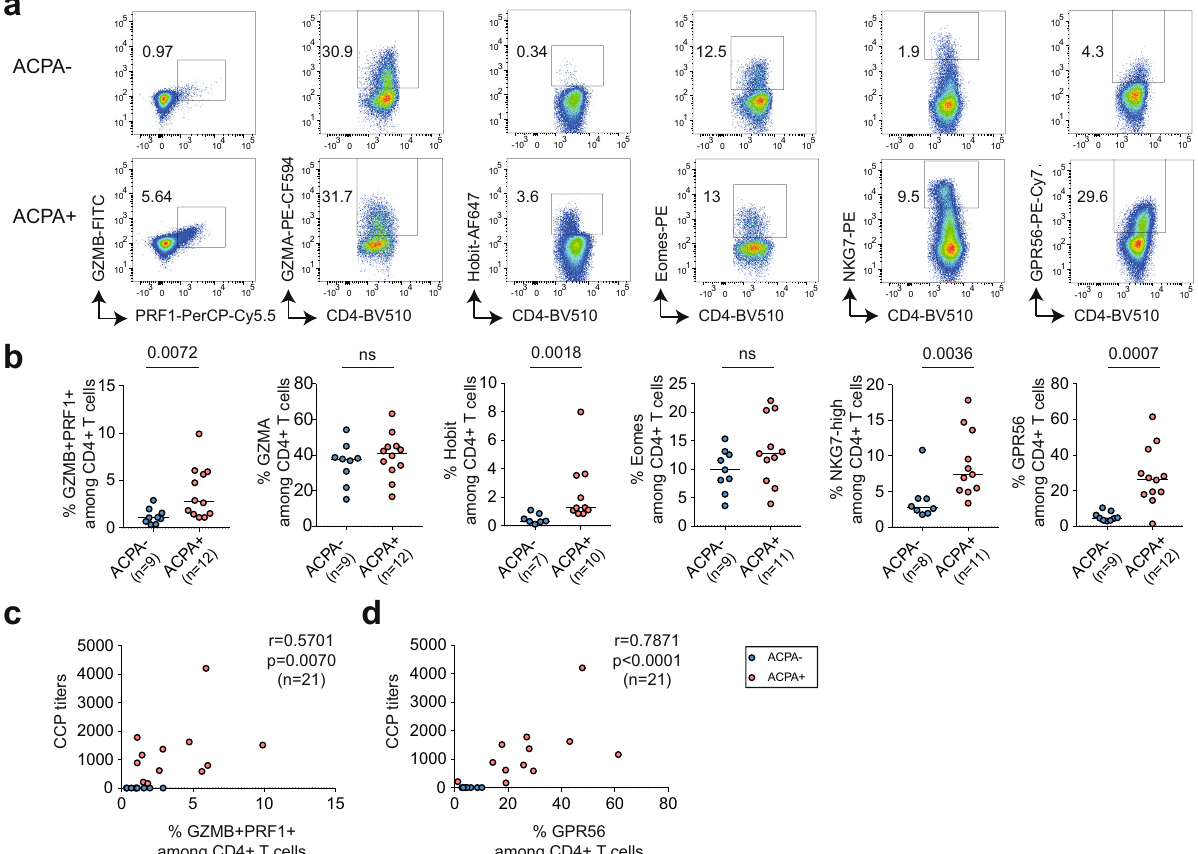
Fig. 1 Cytotoxic CD4 + T-cell frequency in synovial fl uid of ACPA − and ACPA + RA patients. a Representative fl ow cytometry dot plot staining of effector molecules, receptors and transcription factors associated with cytotoxic functions in CD4 + T cells from synovial fl uid (SF) from ACPA − (upper panel) and ACPA + (lower panel) RA patients, quanti fi ed in b , (ACPA − , n = 7 – 9) (ACPA + , n = 10 – 12). Line represents median, two-tailed Mann – Whitney U test, P = 0.0072 (%GZMB + PRF1 + ), ns (%GZMA), P = 0.0018 (%Hobit), ns (%Eomes), P = 0.0036 (%NKG7-high), P = 0.0007 (%GPR56), ns: not signi fi cant. c Correlation between the frequency of GZMB + PRF1 + in CD4 + T cells in SF and the level of serum anti-CCP (cyclic citrullinated peptide) antibodies, n = 21, Spearman two-tailed test, P = 0.0070. d Correlation between the frequency of GPR56 in CD4 + T cells in SF and the level of anti-CCP (cyclic citrullinated peptide) antibodies, n = 21, Spearman two-tailed test, P < 0.0001. a – d Data are from a pool of nine independent experiments where a circle is a single replicate. Blue dots indicate ACPA − RA SF and red dots indicate ACPA + RA